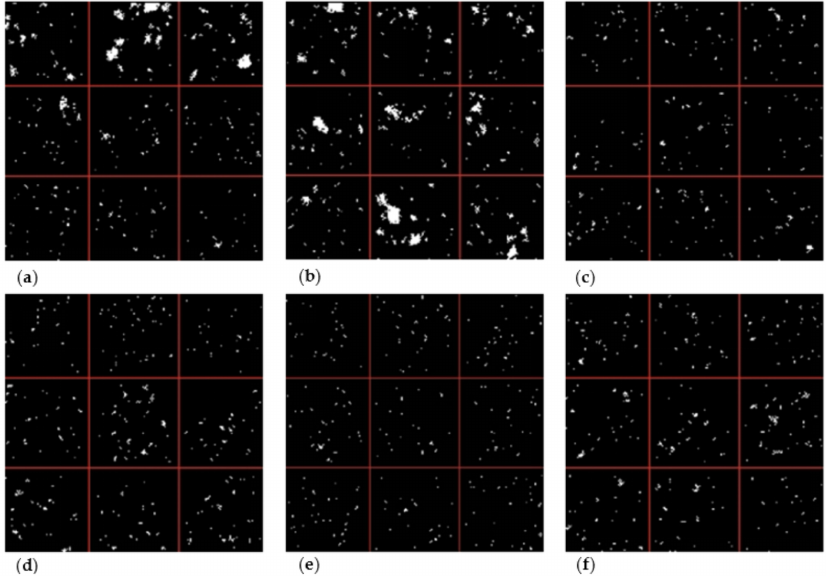
Figure 4. Simulation results: ( a ) A third seeking model with N = 20, α = 1.2, and T = 15, ( b ) Seeking model with N = 20, α = 1.2, and T = 15, ( c ) Neutral model with N = 20 and T = 15, ( d ) A third aversion model with N = 20, α = 1.2, and T = 15, ( e ) Averse model with N = 20, α = 1.2, and T = 15, and ( f ) Neutral model with N = 20 and T =